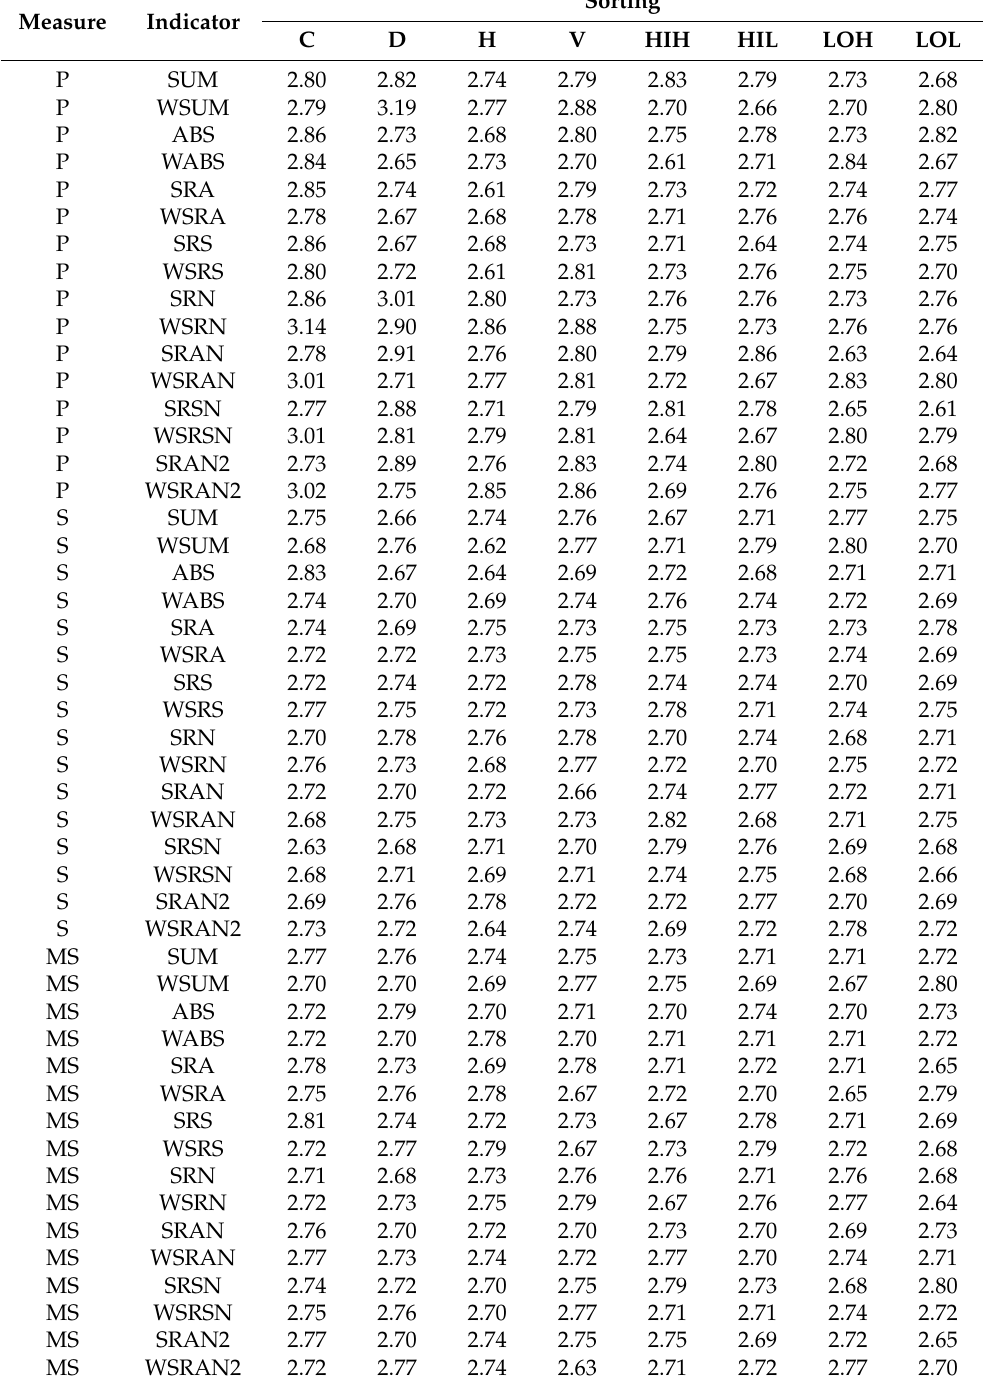
Table 8. Computational results for the NEH algorithm: ARPD values